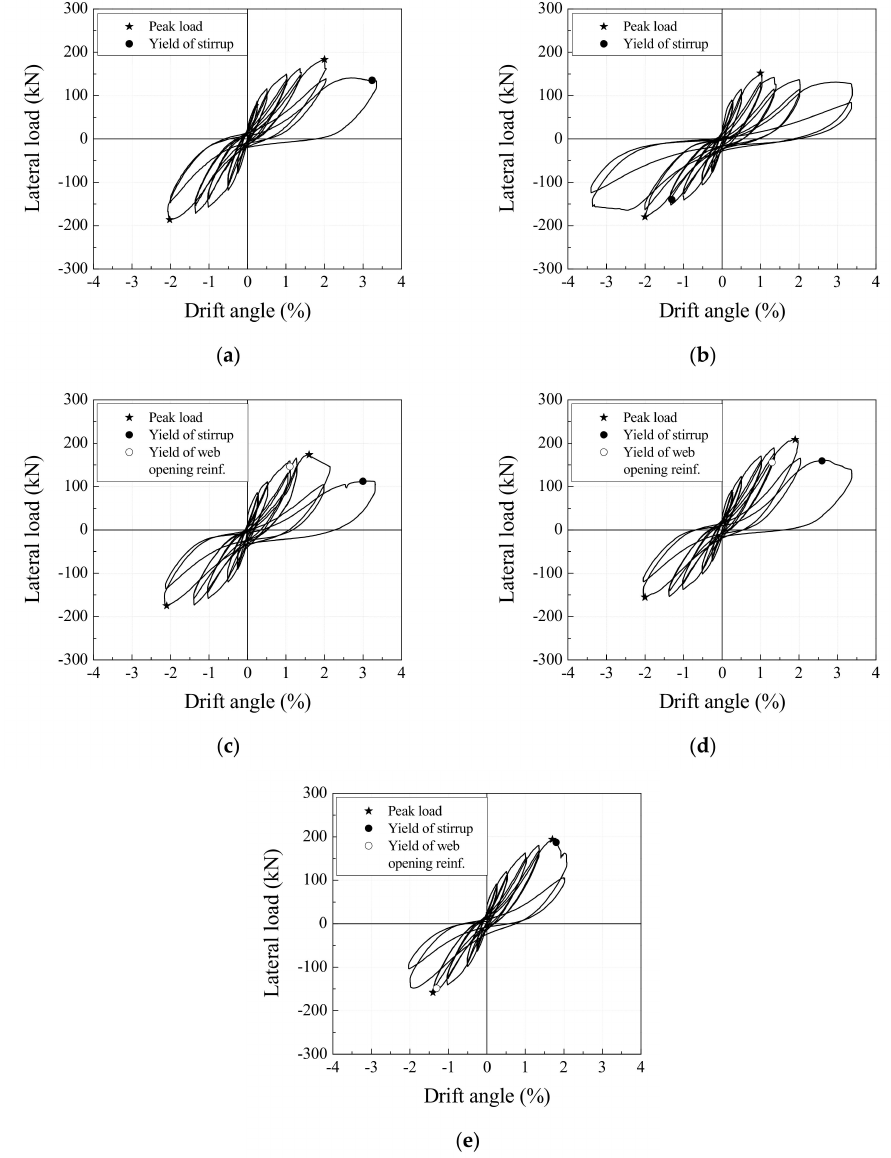
Figure 5. Lateral load-drift angle relations: ( a ) No. 1; ( b ) No. 2; ( c ) No. 3; ( d ) No. 4; ( e ) No.